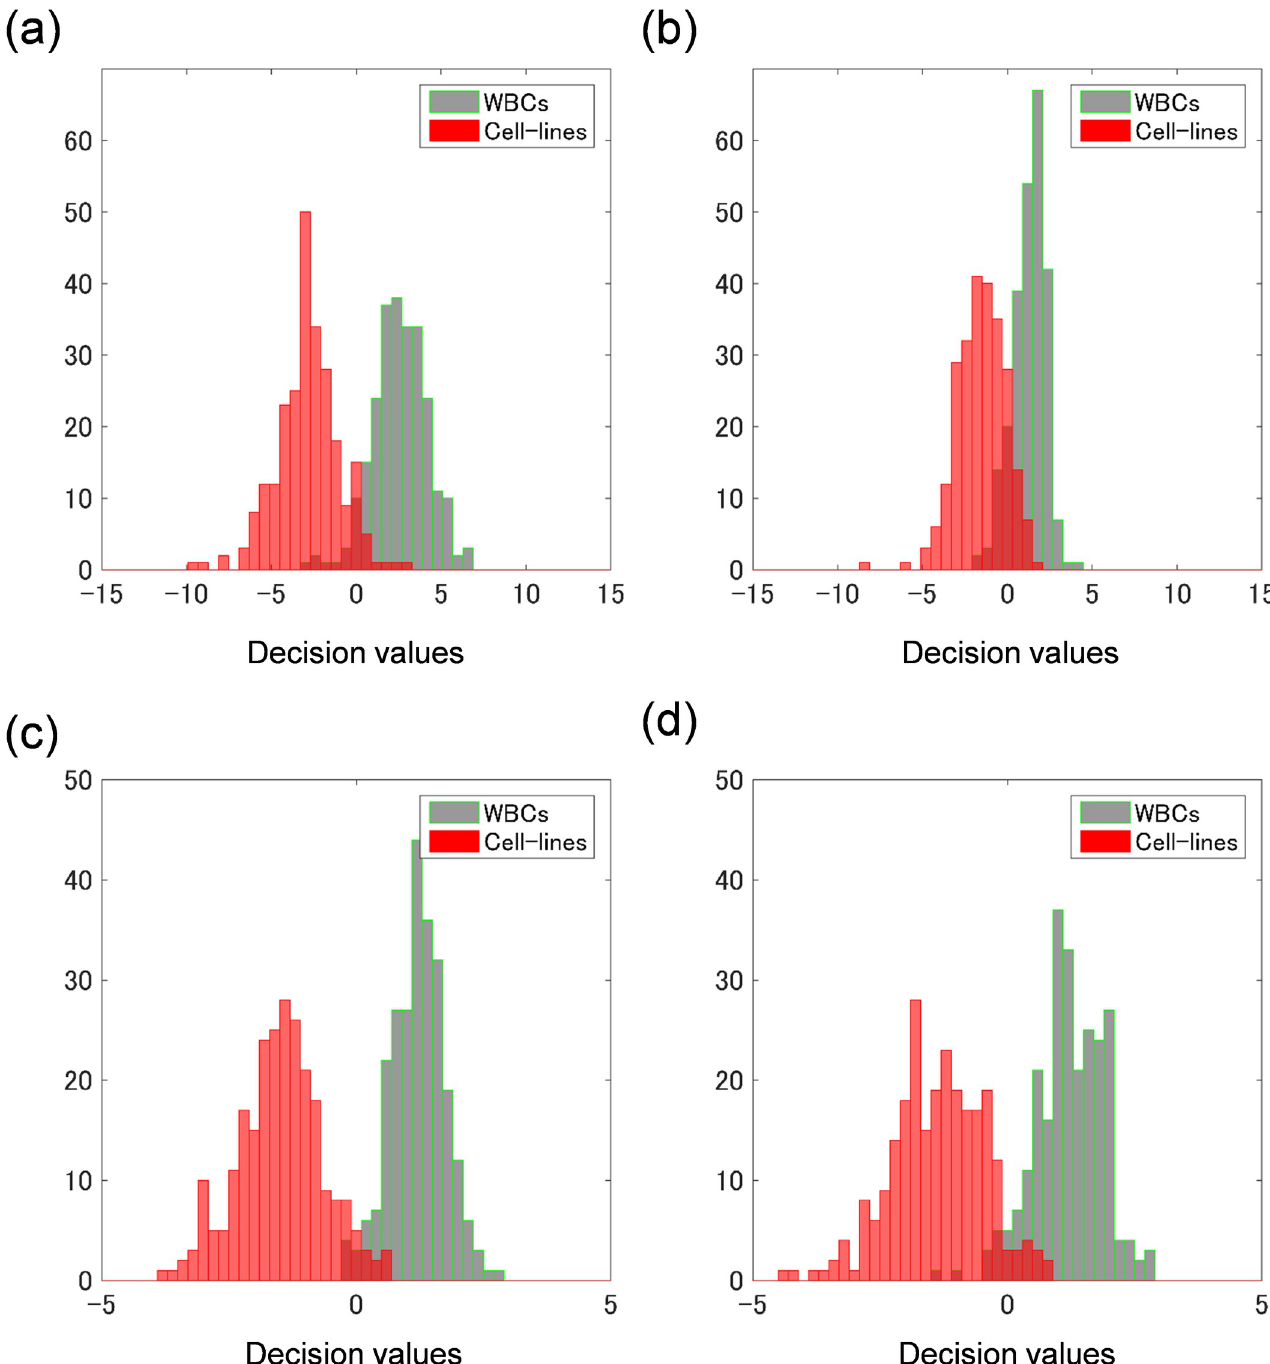
Fig 9. Histograms of decision values of training-data sets. Positive decision values for each cell are classified as a WBC, whereas negative decision values are classified as a cell line. Most WBCs (green bars) are classified as a positive decision value, and most cell lines (red bars) are classified as a negative one. The training data set consists of (a) statistical features of OPL/PL, (b) statistical features of OPL/D, (c) HOG features of OPL/PL, and (d) HOG features of OPL/D.